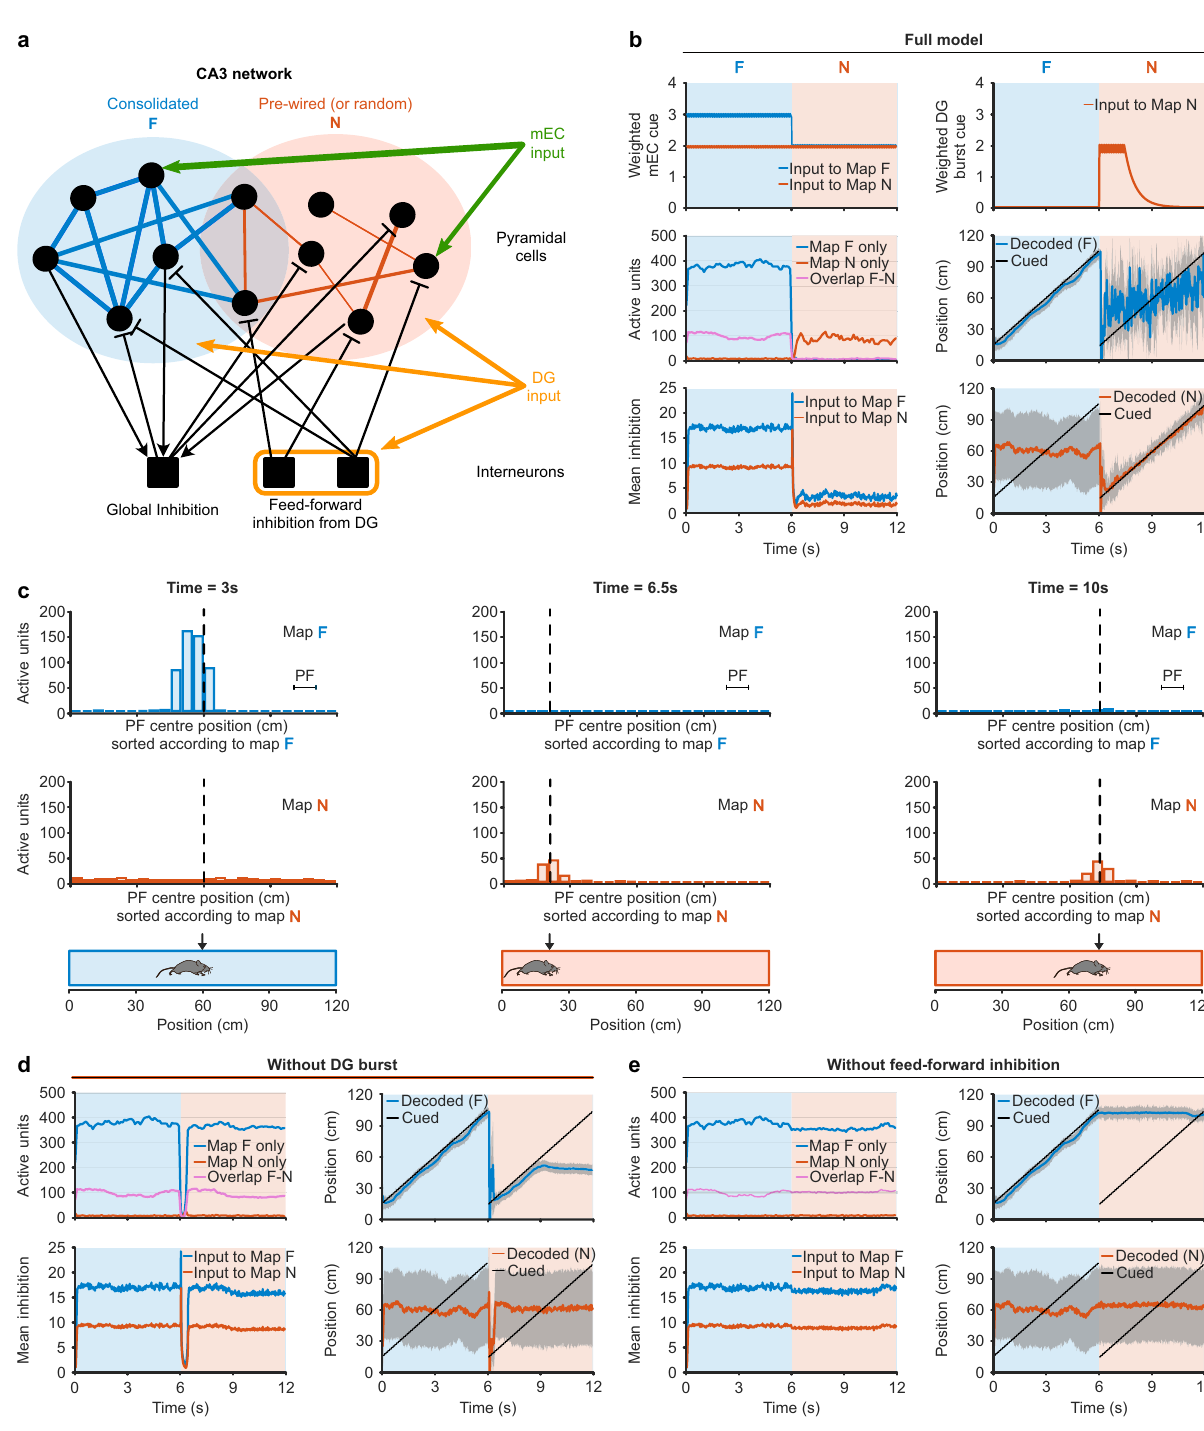
PF centre position (cm) sorted according to map